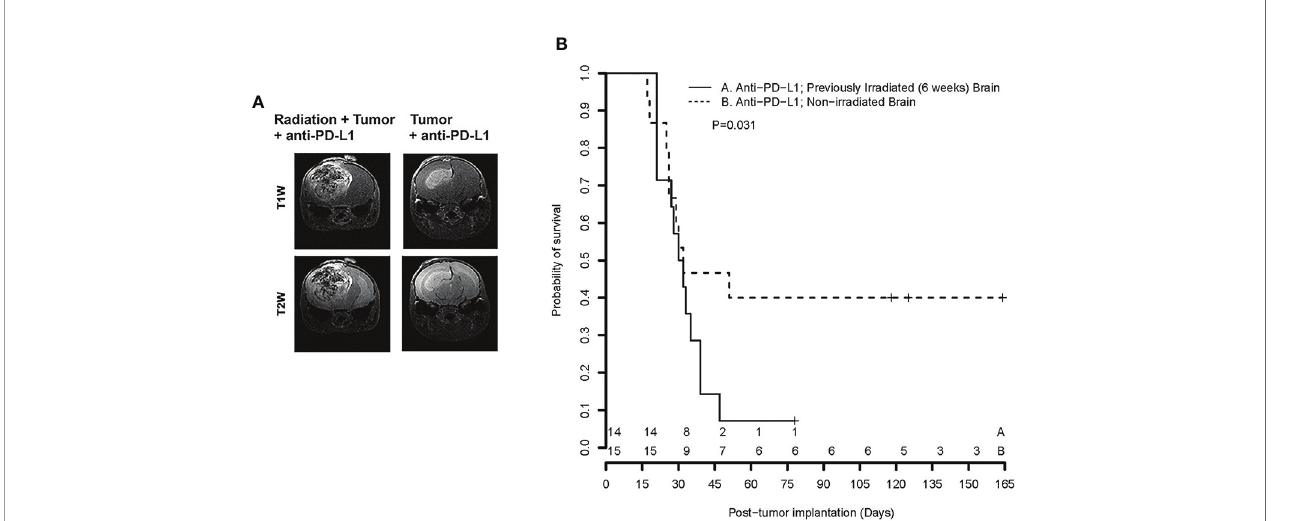
FIGURE 3 | (A) Representative contrast-enhanced, T1- and T2-weighted MR images of the brains of C57Bl/6 mice, previously irradiated focally, or not, implanted with GL261 cells in the irradiated hemisphere and treated with anti-PD-L1 therapy; (B) Kaplan-Meier curves show that survival of tumor-bearing mice whose brains were not irradiated (n = 15; dashed line) is signi fi cantly greater than for mice whose brains were irradiated six weeks prior to tumor implantation (n = 14; solid line), p = 0.031 [extended log-rank test (22)]. + signs indicate mice that were sacri fi ced for histology; numerals near the bottom of the plot re fl ect the number of surviving